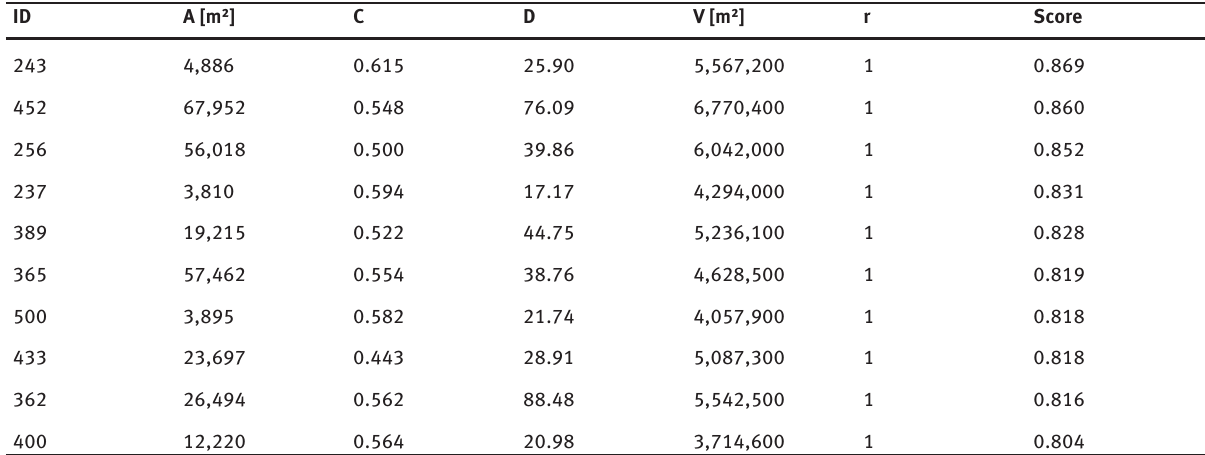
Table 3: The ten iMounds with the highest score including all parameters used for the calculation. A: Area, C: Circularity, D: Availability of fresh water (accumulated costs), V: Visibility, r=1 if manmade structures are visible in the LiDAR